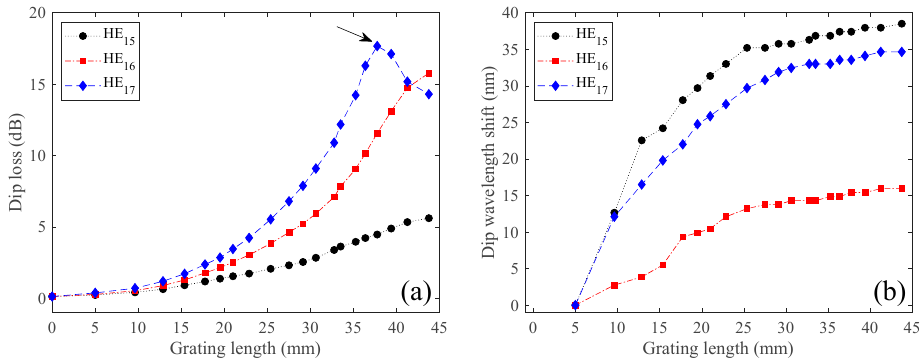
Figure 7. ( a ) Dip attenuation and ( b ) dip wavelength shift as function of the grating length, obtained for the LPG grating spectra shown in Figure 6.